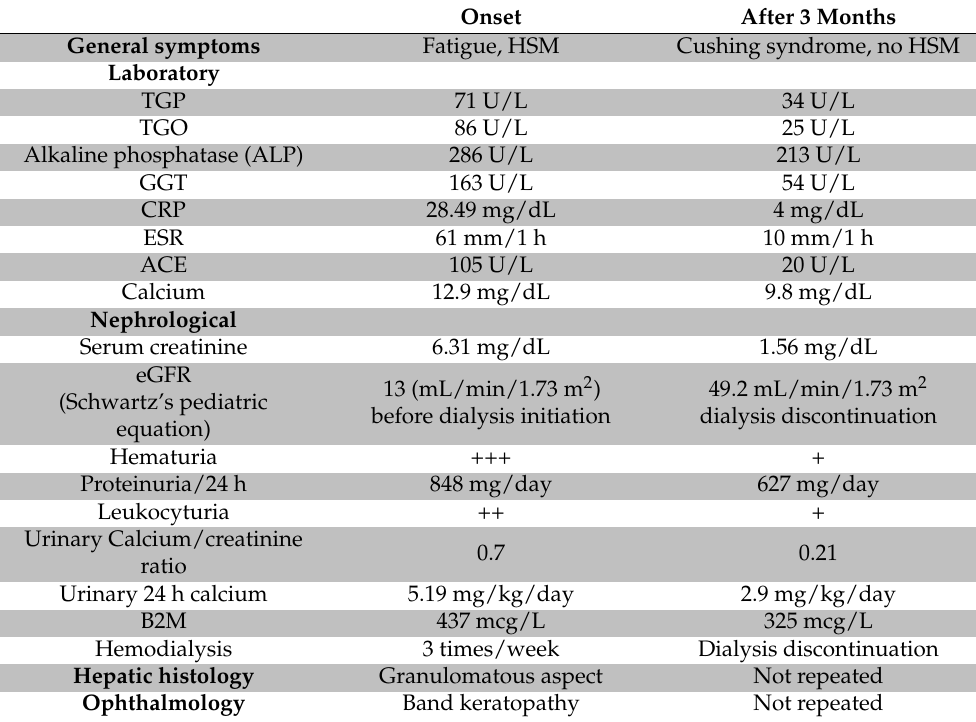
Table 1. Clinical, biological, and histopathological parameters at onset and 3 months after pred- nisolone therapy. Onset After 3 Months Fatigue,